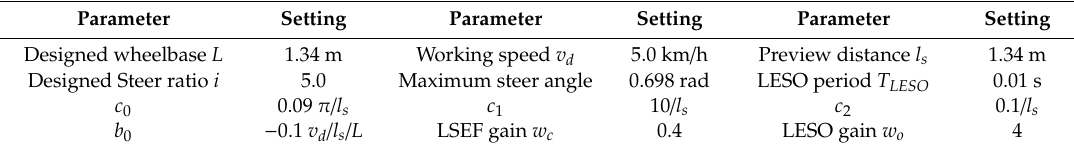
Table 1. Key parameters.